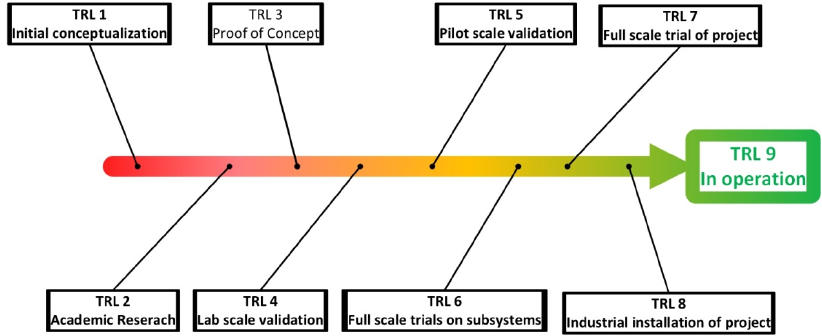
Figure 3. An overview of different TRL levels as interpreted for resource recovery